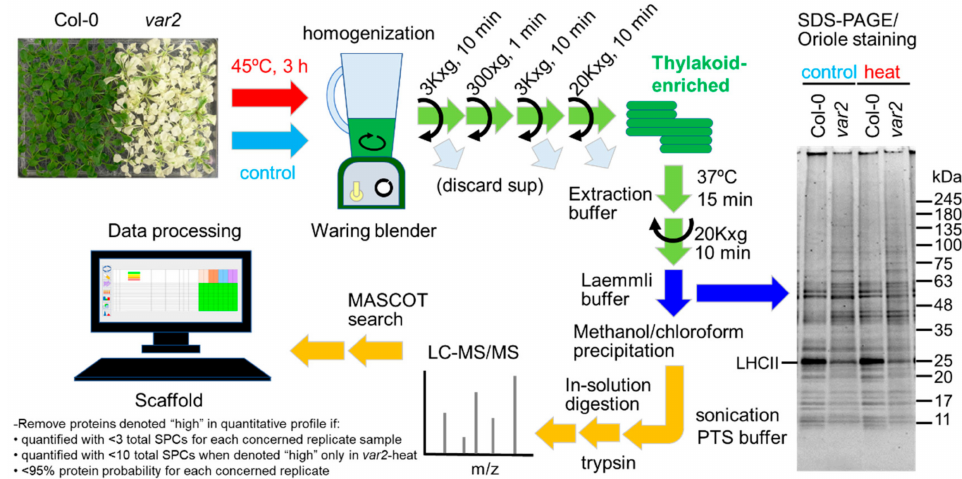
Figure 1. Workflow for analyzing thylakoid-enriched proteomes of var2 mutant vs wild type Arabidopsis under normal and heat stress conditions. Wild-type Col-0 and var2 mutant plants were grown on plates under normal conditions and then harvested before (control) or after heat stress (45 ◦ C, 3 h), followed by homogenization. The homogenates were fractionated by a series of centrifugation processes to obtain thylakoid enriched fractions. Their proteins were extracted and analyzed by SDS-PAGE followed by Oriole staining (3 µ g of proteins per lane). The protein extracts were methanol-chloroform precipitated for in-solution digestion with trypsin for LC-MS/MS analysis. Obtained mass spectra were subject to MASCOT search, and identified proteins were analyzed by Scaffold. Differentially accumulated proteins were searched using Scaffold with the indicated criteria (see method). SPC, spectrum count.